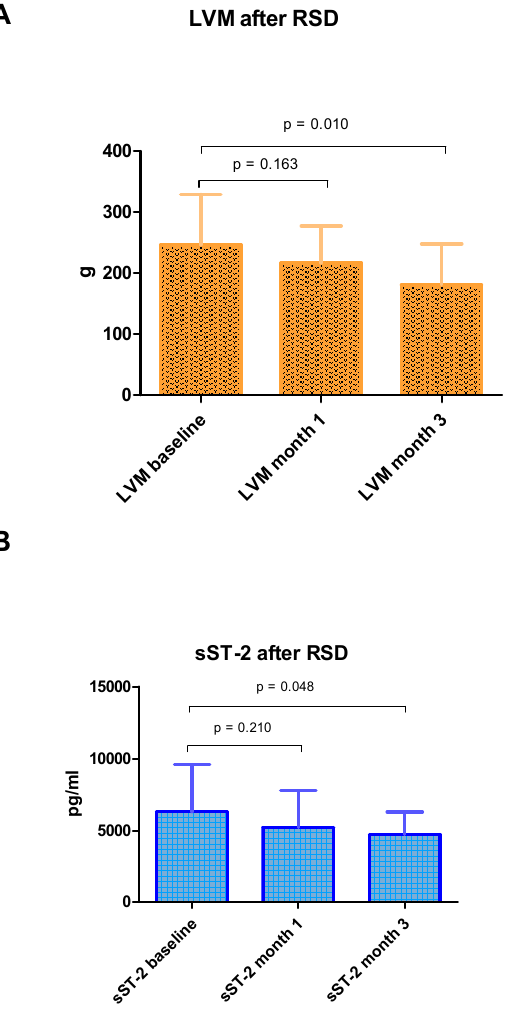
Figure 2. Alterations of LVM post RSD documented in TTE ( A ) and sST-2 levels post RSD ( B ). Statistical significance calculated by Student’s t -test.